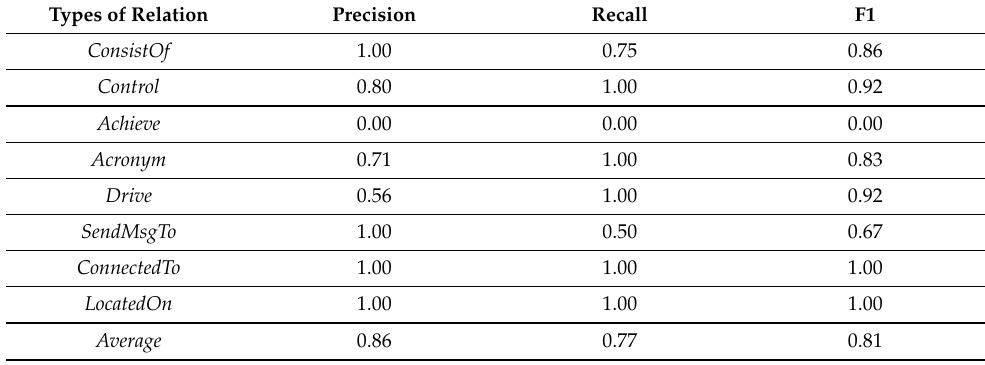
Table 7. Two-stage method: relation extraction results based on annotated entities.